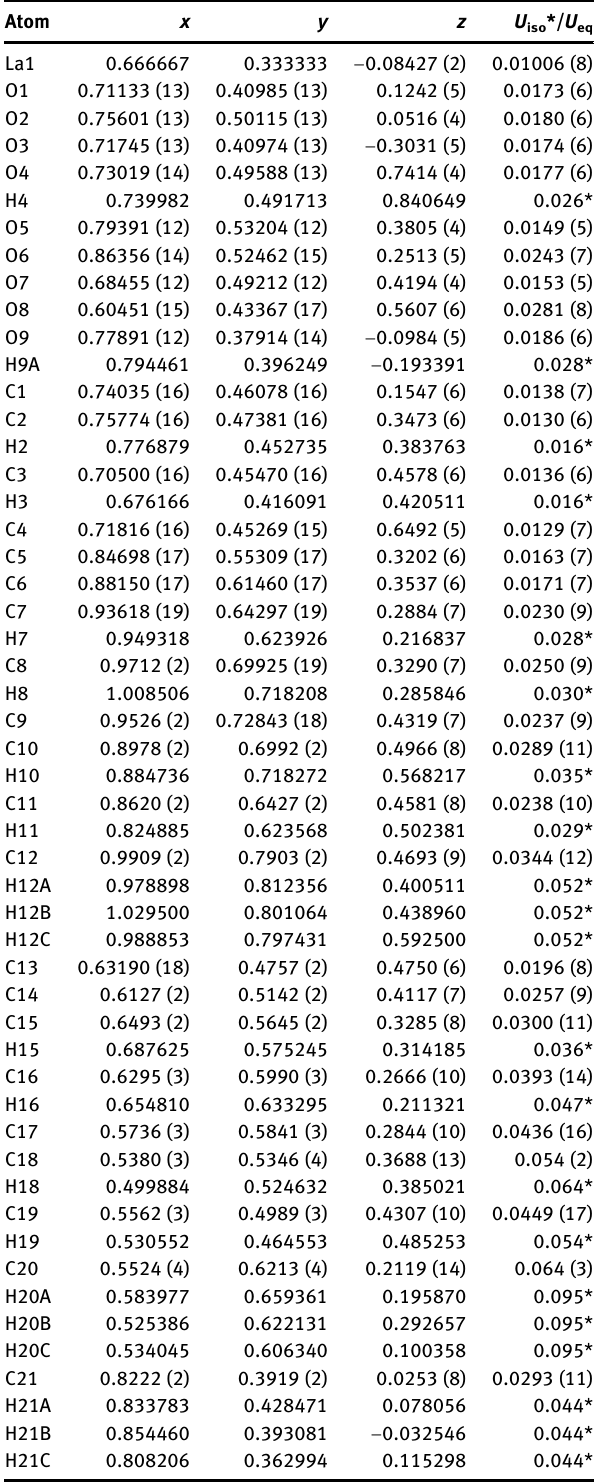
Table  : Fractional atomic coordinates and isotropic or equivalent isotropic displacement parameters (Å 